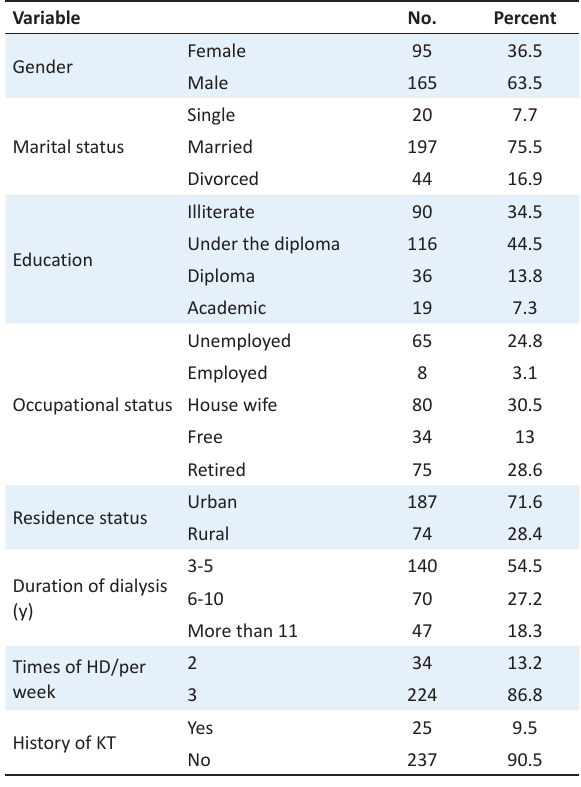
Abbreviations: HD, Hemodialysis; KT, Kidney